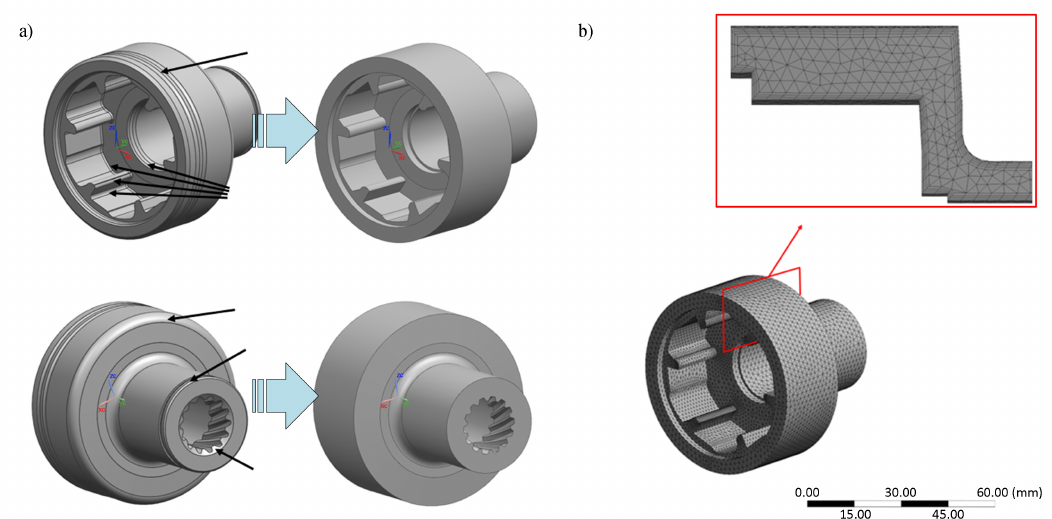
Figure 1. ( a ) Geometry of the starter clutch barrel and its simplification—arrows show the simplified details. ( b ) Finite element mesh—mesh density increases towards the outer surface in order to simulate high surface gradients during the heat treatment process.